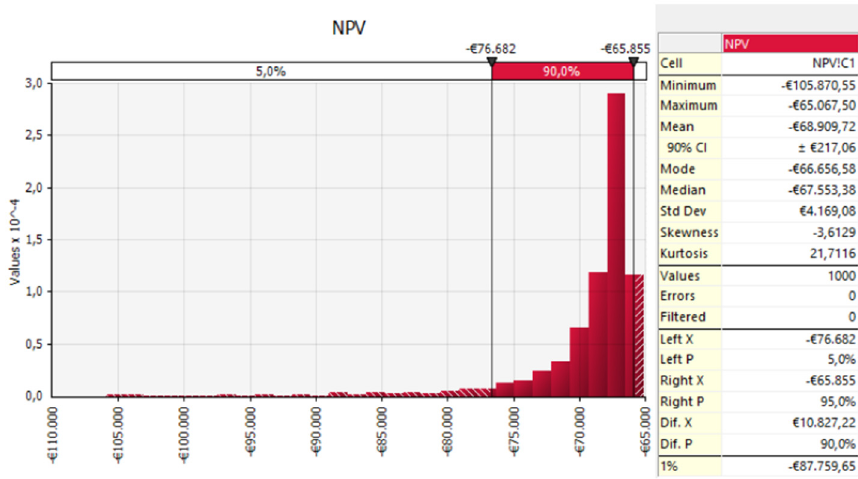
Figure 14. Monte Carlo analysis of the